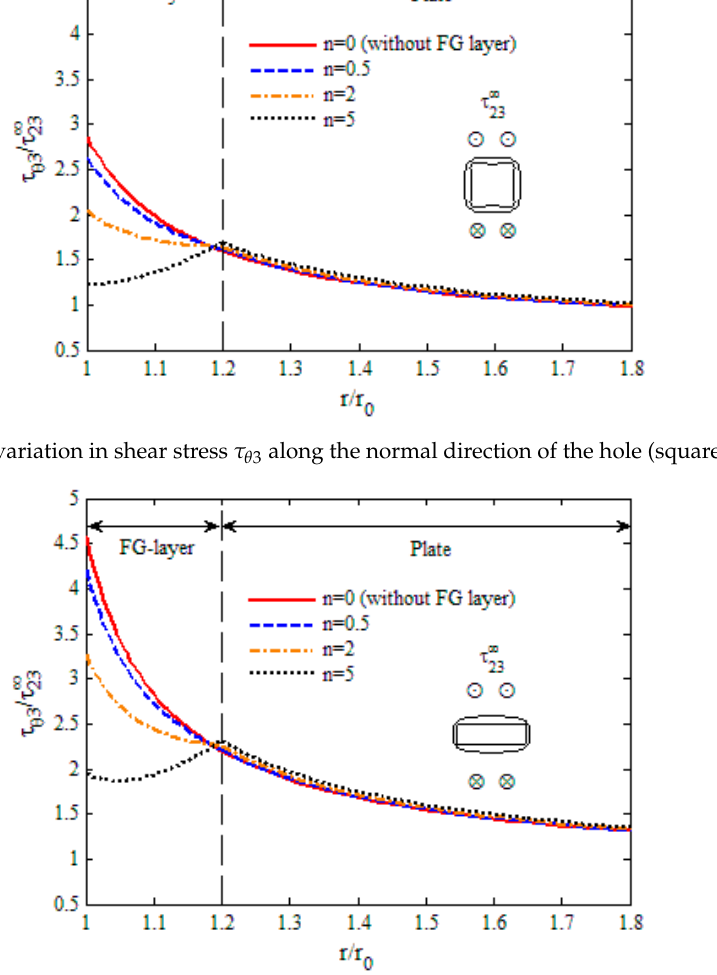
Figure 12. The variation in shear stress τ θ 3 along the normal direction of the hole (rectangle, δ = 29 ◦ ).